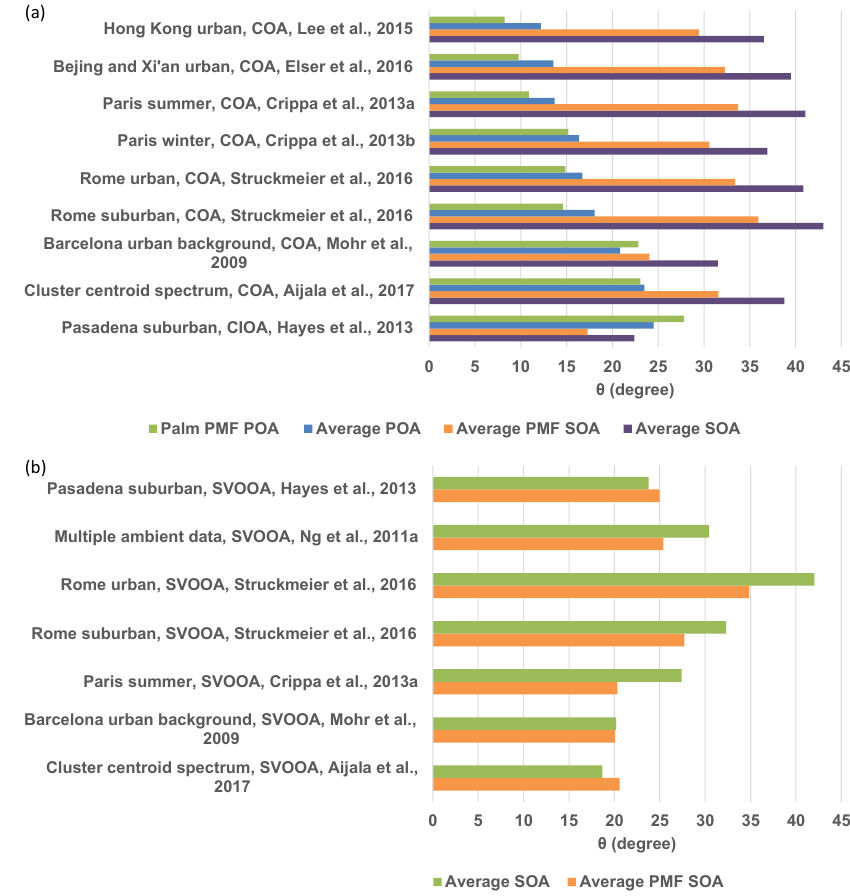
Figure 6. (a) Angles ( θ) between ambient COA factor mass spectra and the palm PMF POA mass spectrum, average POA mass spectrum, average PMF SOA factor mass spectrum, and average SOA mass spectrum. (b) Angles ( θ) between ambient SVOOA factor mass spectra and the average PMF-derived SOA factor and average SOA mass spectra. The average POA mass spectra were averaged for sunflower, peanut, corn, and canola oils (Liu et al., 2017). The average SOA mass spectra were averaged for sunflower, peanut, corn, canola, and soybean oils in this